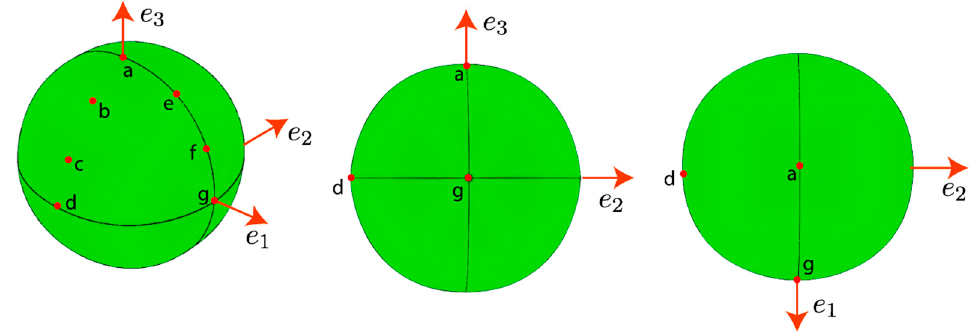
Figure 8. Curvature mapping over the constructed geometry (unripe orange).